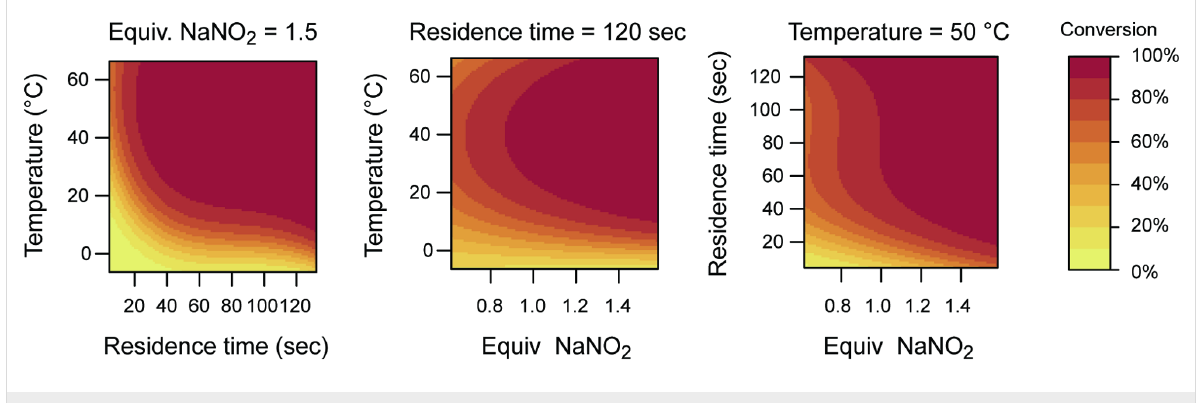
Figure 3: 2D-Contour plots of the multivariate optimization.